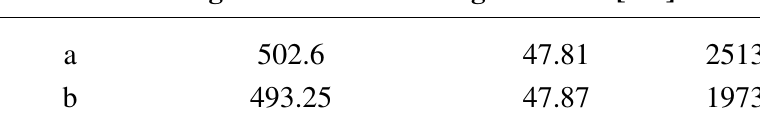
Table 1. Average number of packets sent and average transmission rate including protocol overhead for all lab setup packet loss rate measurements with IPANEMA generation 2 nodes. n = the total number of generated packets for each